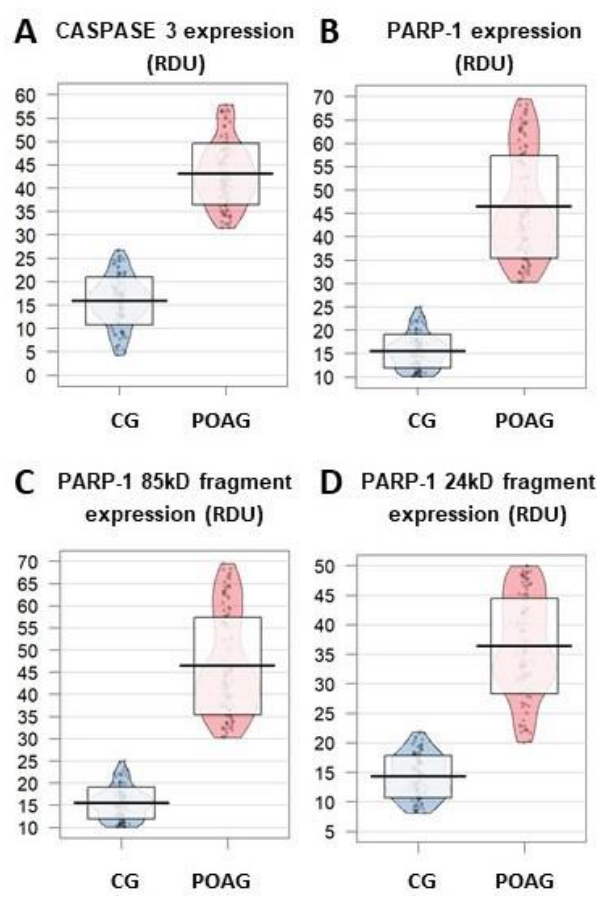
Figure 5. Di ff erential expression profile (relative densitometric units) in the aqueous humor from the glaucoma vs. the control participants. The CASP3 ( A ) and PARP-1 ( B ) were significantly higher in the POAG vs. the CG. Comparison of the expression profile of the PARP-1 85 kD and 24 kD fragments between the aqueous humor from the POAG and the the CG are reflected in ( C ) and ( D ). CASP3: caspase 3; CG: control group (cataract subjects forming the comparative group); POAG: primary open-angle glaucoma; RDU: relative densitometric units (laser densitometry); PARP-1: poly (ADP-ribose) polymerase.